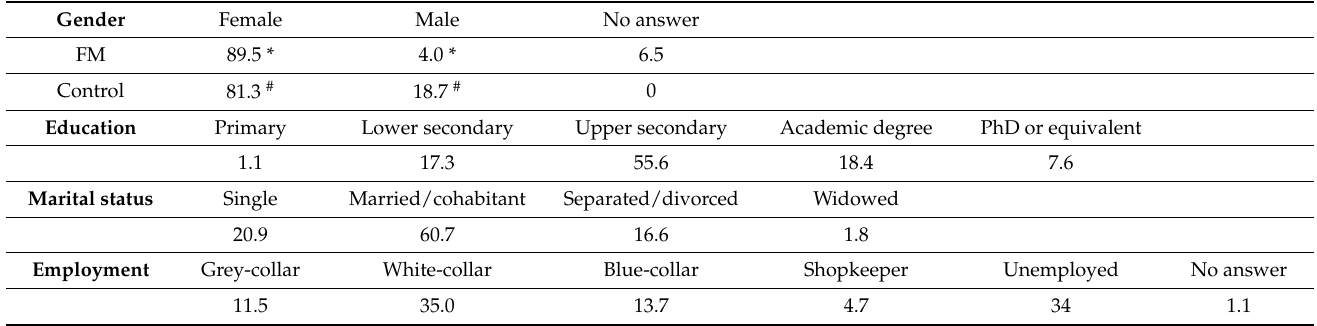
Figure 1. Workflow of participant inclusion/exclusion criteria and process applied in the study. Table 1. Percent distribution of demographics in Fibromyalgia (FM) participants ( n = 277) and of gender in Controls ( n = 80).